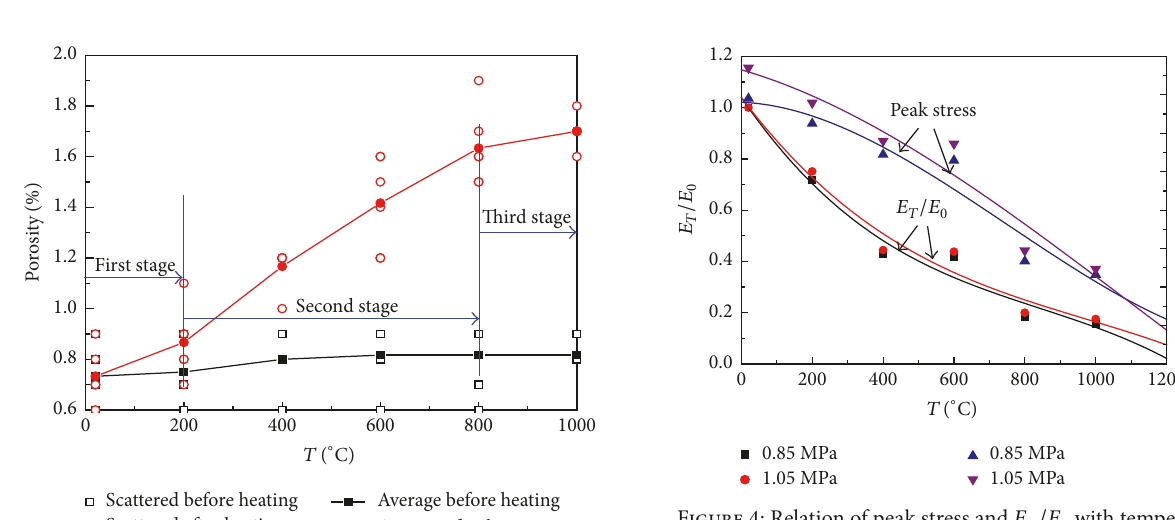
Figure 4: Relation of peak stress and 𝐸 𝑇 /𝐸 0 with temperature. unchanged. Above 600 ∘ C, dynamic peak stress